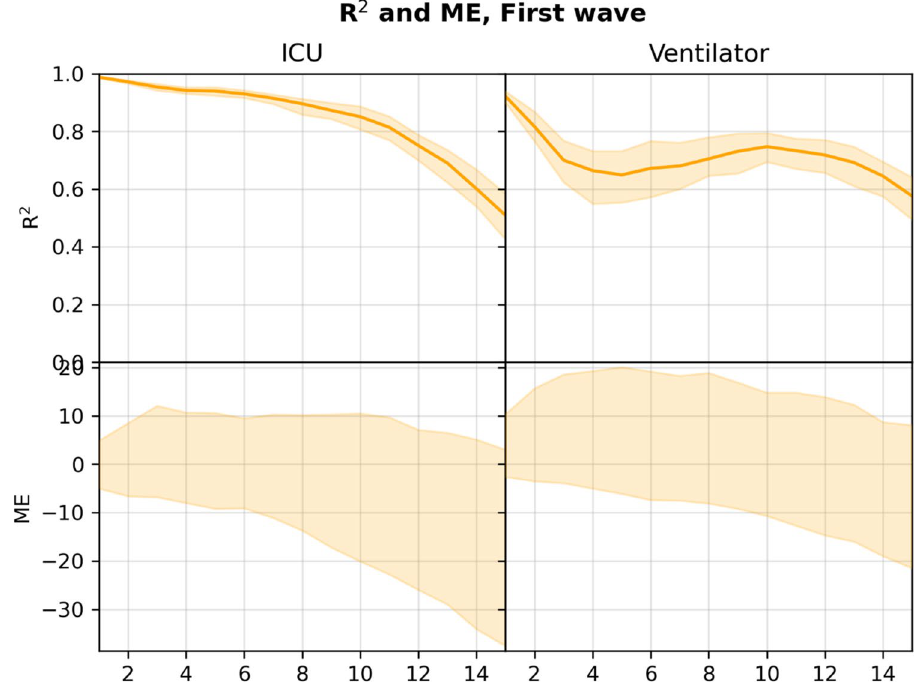
Figure 5. R 2 and 95% confidence interval (top), and ME (bottom) for n -day forecasts using the RF model in the first wave setting, computed on the pooled predictions for the months after June 2020. Numerical results are given in Supplementary Tables 7 and 8.